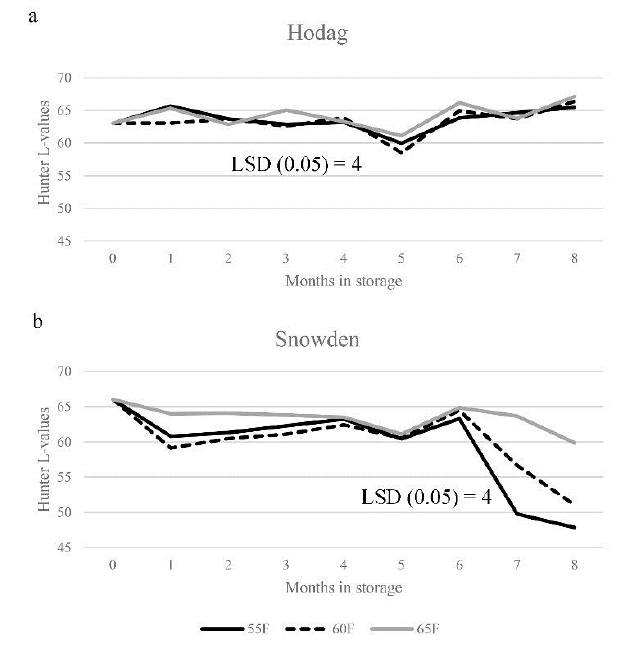
Figure 9. Hunter L-values of Hodag ( a ) and Snowden ( b ) under the three wound healing treatments in 2017.